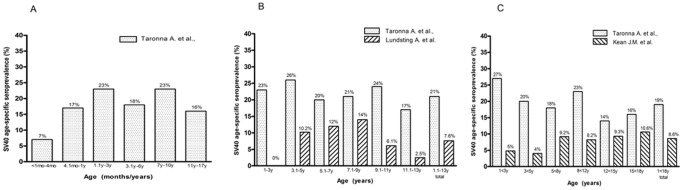
Comparison of SV40 age-specific seroprevalence of antibodies.Comparison of SV40 age-specific seroprevalence of antibodies among 214 Italian children and adolescents, <1–17 year old (this study), Panel A; compared to 288 Swedish children aged between 1 and 13 year old [16] Panel B; and compared to 629 U.S. children and adolescents aged between 1 and 18 year old [17], Panel C.